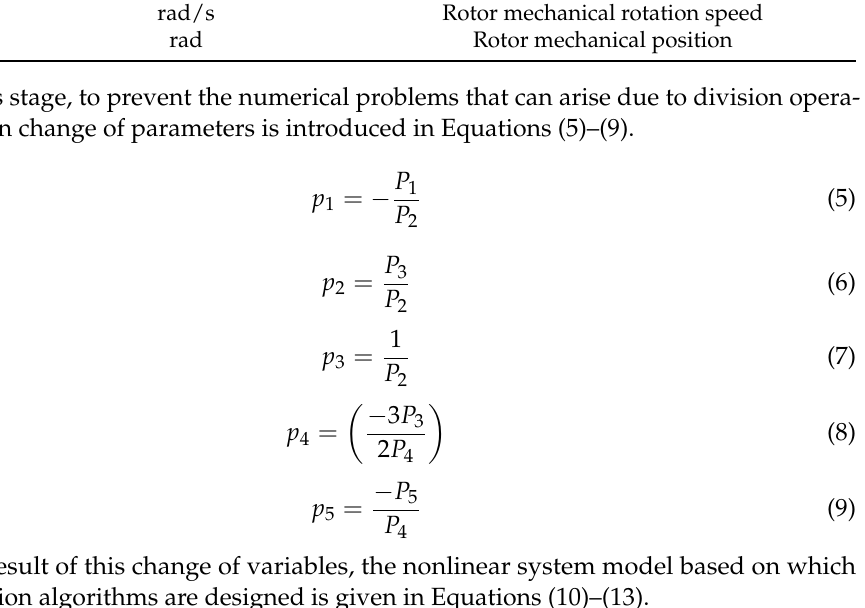
Table 2. The plant states and definitions. Parameter Unit Definition x 1 A Direct-axis stator winding current x 2 A Quadrature-axis stator winding current x 3 rad/s Rotor mechanical rotation speed x 4 rad Rotor mechanical